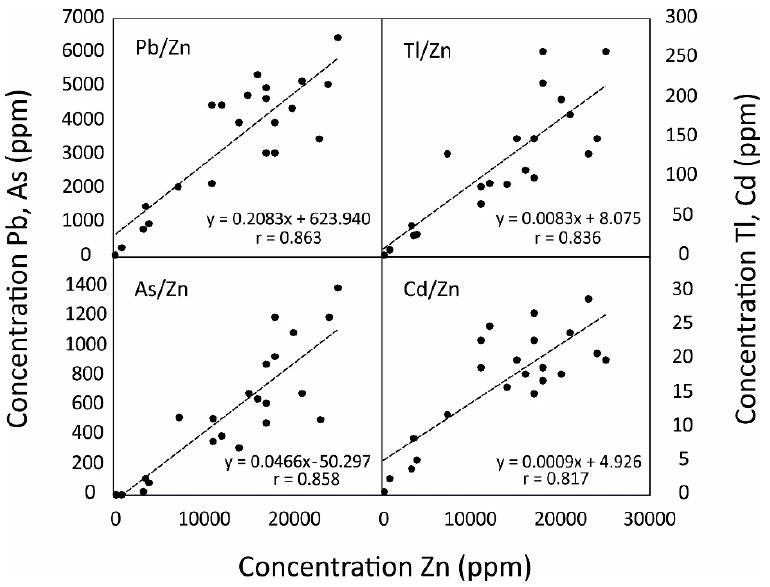
Figure 8. Scatterplots of the borehole samples with the related regression lines between Zn and Pb, Tl, As and Cd concentrations.